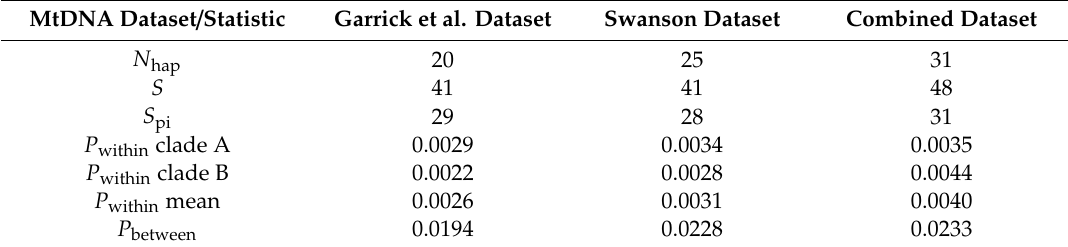
Table 4. Characteristics of mtDNA sequence data generated from O. disjunctus individuals